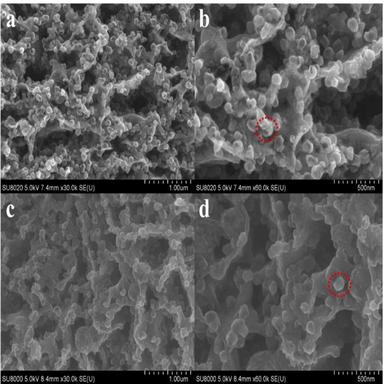
The SEM images with different magnification of Co-SPCP (a and b) and Co-SPCP/S composites (c and d).